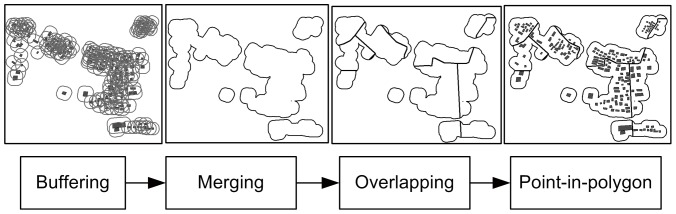
Data set partitioning.The data set partitioning method has four major steps: (1) buffering of buildings, (2) merging of buffering polygons, (3) conducting an overlap with street network, and (4) processing a point-in-polygon operation to assign each building to the corresponding partition.